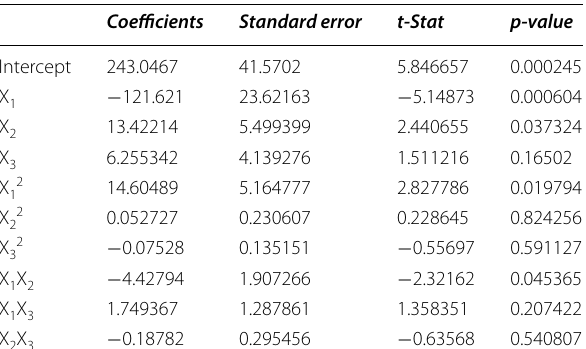
Table 5 Analysis of CCD for xylanase activity